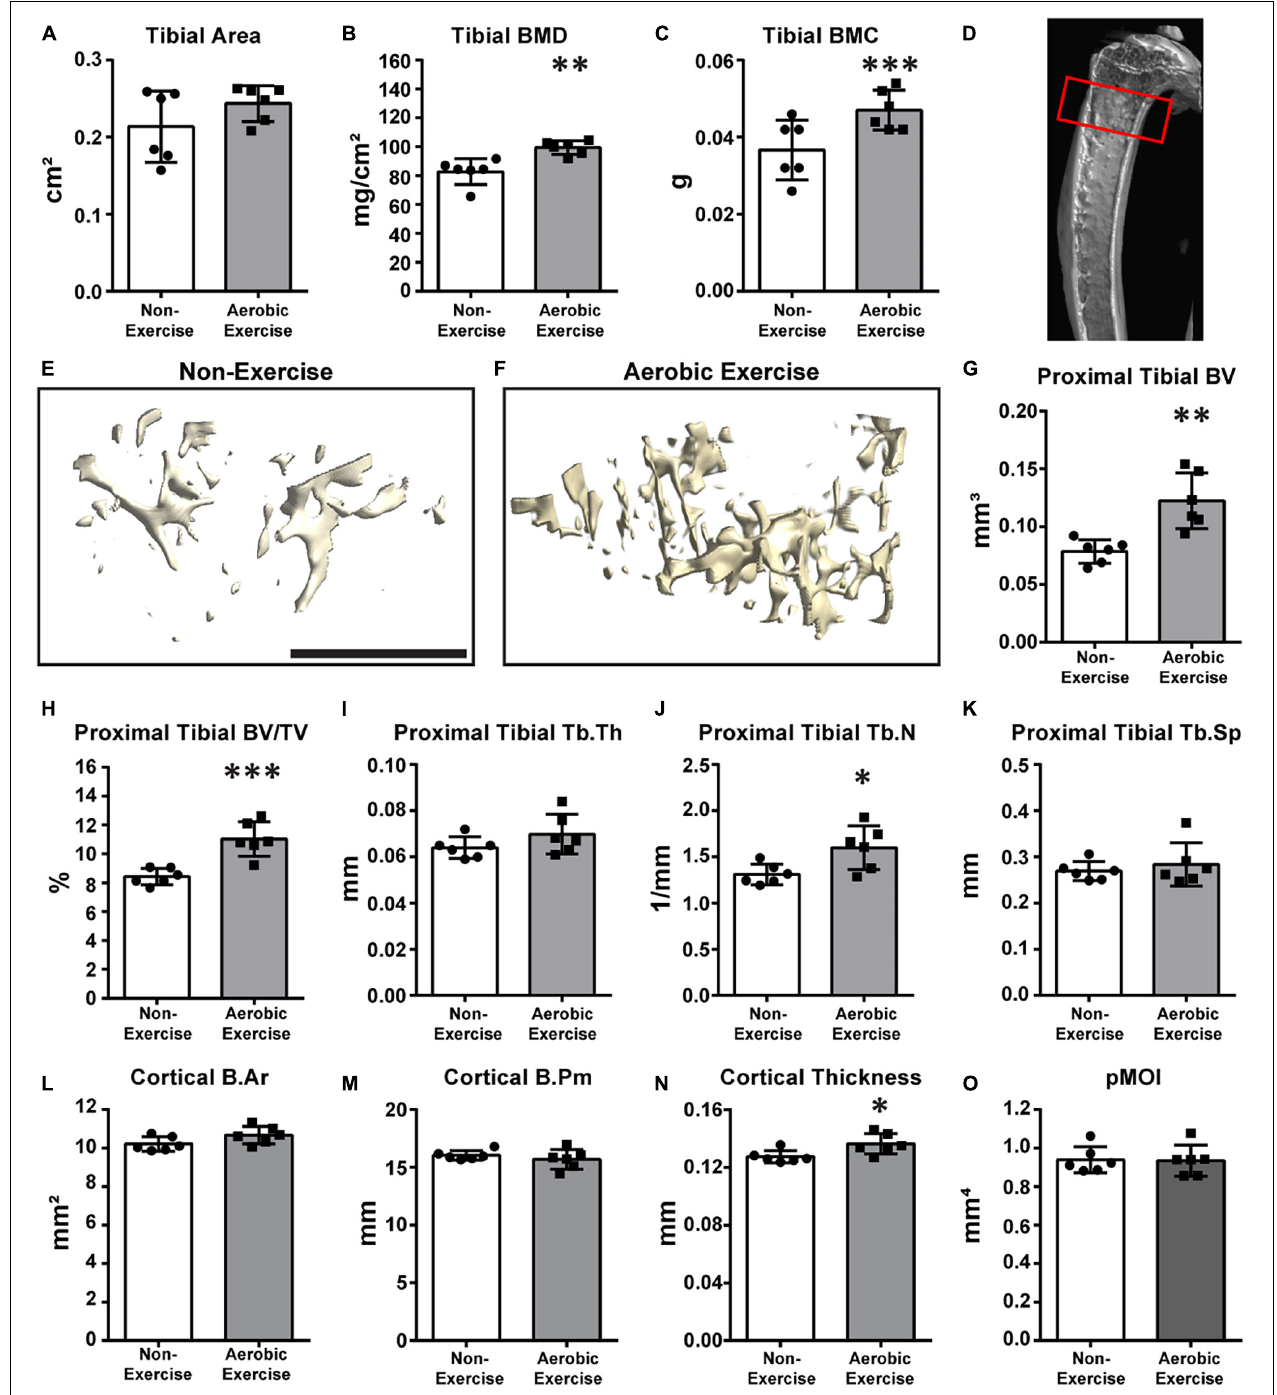
FIGURE 2 | Aerobic exercise training demonstrates greater proximal tibial BMD, BMC, trabecular bone microarchitecture, and cortical bone perimeter. Quantification of area, BMD, and BMC of proximal tibiae (A–C) . Tibial area did not differ between groups (A) . Tibial BMD [ (B) p < 0.01] and BMC [ (C) p < 0.001] of mice in Aerobic Exercise group were significantly different from mice in the Non-Exercise group. Representative 3D µ CT reconstruction images of region of interest [ (D) red box] and proximal tibial trabecular bone microarchitecture in Non-Exercise and Aerobic Exercise groups (E,F) . Proximal tibial BV was significantly higher ( p < 0.01) in Aerobic Exercise group vs. Non-Exercise group (G) . Tibial BV/TV was also greater ( p < 0.001) with aerobic exercise training compared to no exercise (H) . Tibial Tb.Th (I) and Tb.Sp (K) were not different between groups. Tibial Tb.N was higher with aerobic exercise vs. without exercise (J) . Cortical thickness was significantly thicker in aerobic exercise group vs. non-exercise group (N) . Cortical B.Ar tended to be higher with aerobic exercise [ (L) p = 0.08], while Cortical B.Pm (M) and pMOI (O) were not different. Black scale bar: 1 mm. N = 6 per group. Values are means ± S.D. ∗ p < 0.05, ∗∗ p < 0.01, and ∗∗∗ p < 0.001.